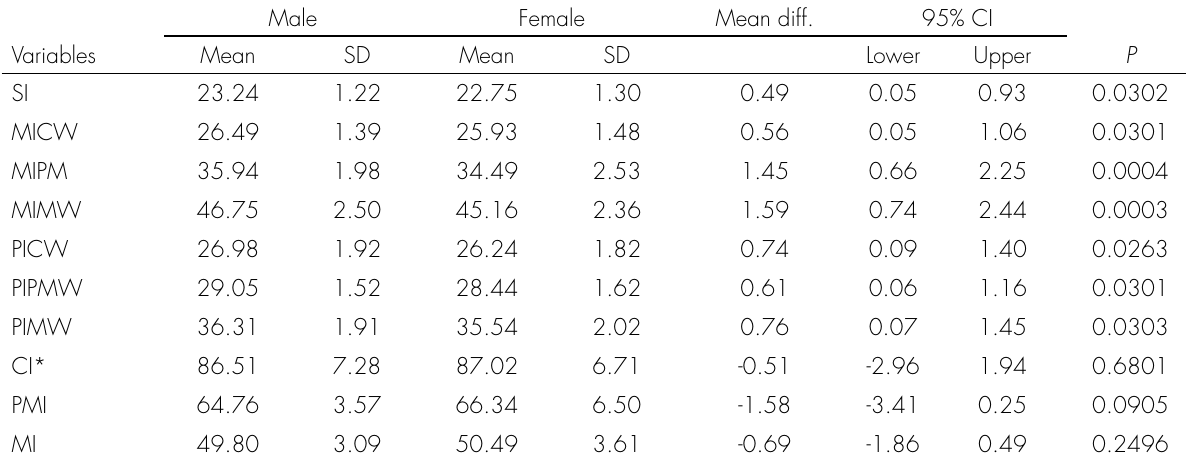
Table II. Comparison of sexual disparities in the sum of the incisors, arch width and expansion indices for the mandibular arch.